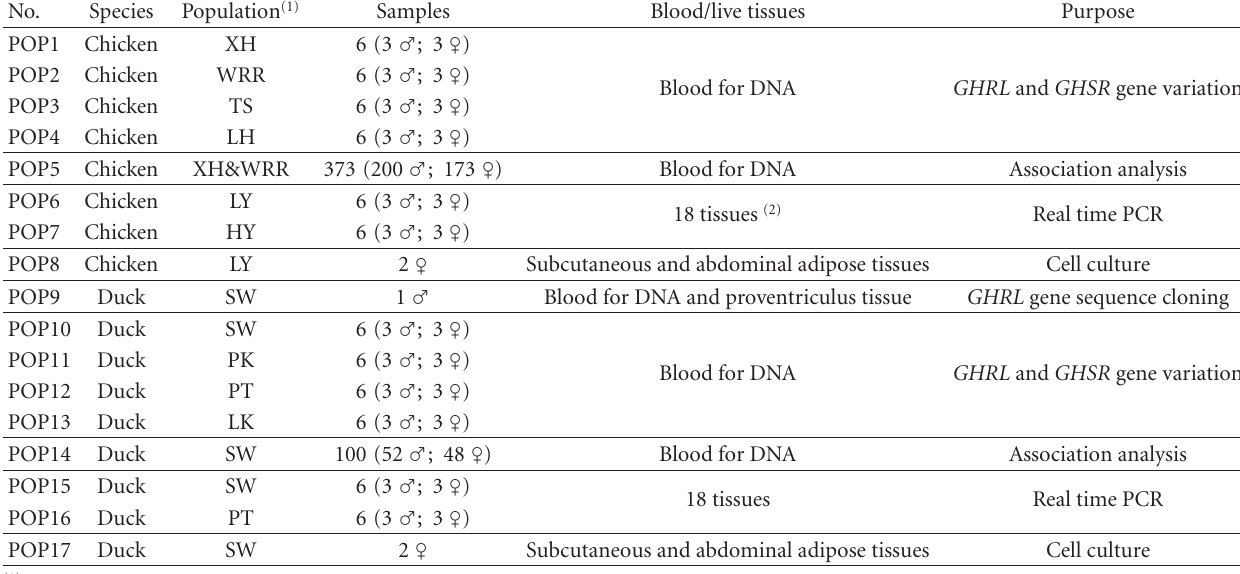
Table 1: Chicken and duck samples used in this